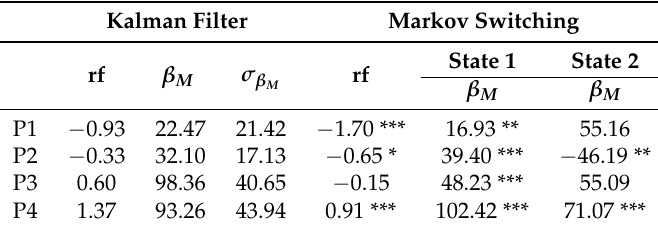
Table 2. The one-factor model estimated by the Kalman filter and Markov switching (MS).